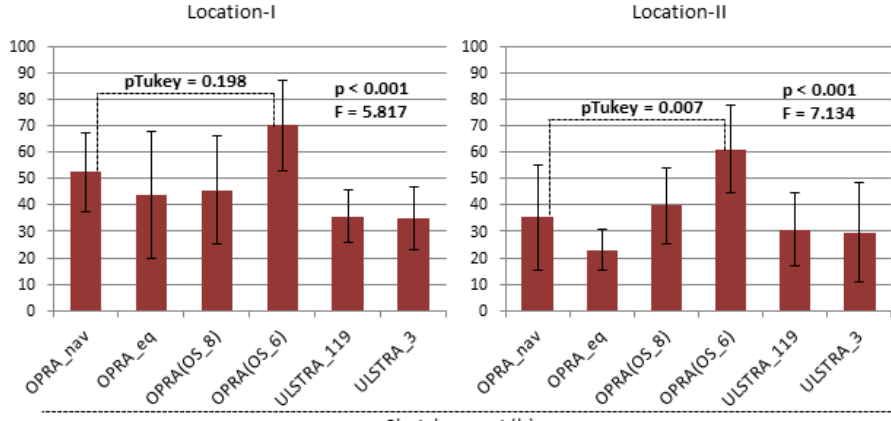
Figure 8: The accuracy of matched street segments using the ULST R and OPRA 8 rep- resentations. The pTukey values between the OPRA ( OS _ 6) and OPRA _ nav show the significant differences in Location-II and insignificant differences in